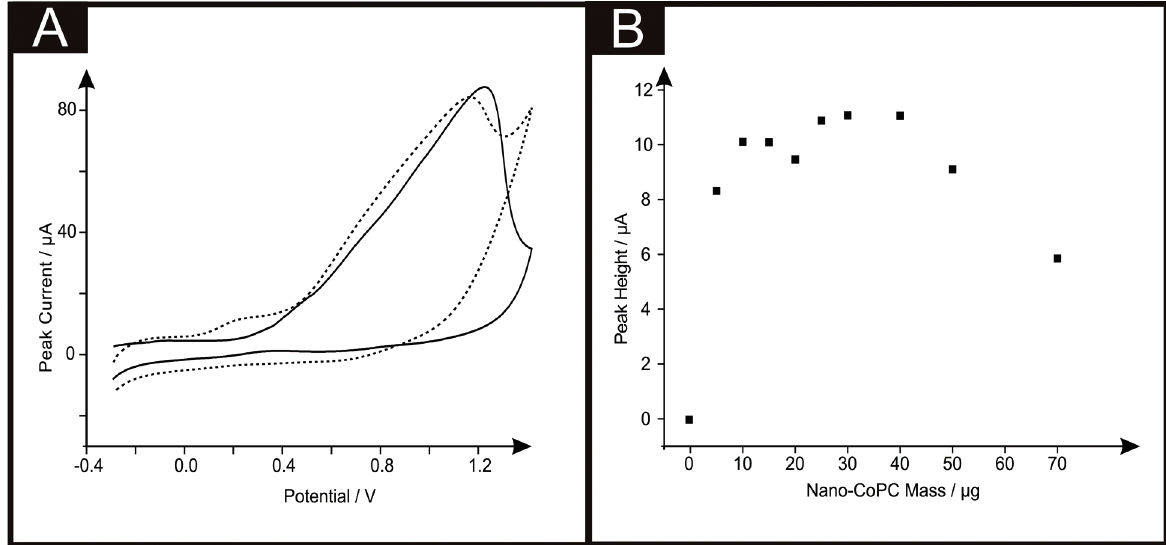
Figure 6. Cyclic voltammograms ( A ) utilising a standard-SPE (solid line), a 20 µg nano-CoTAPC SPE in the presence (dotted line) and absence (dashed line) of 500 µM Hydrazine in pH 7.4 PBS. Corresponding plots of nano-CoTAPC mass vs. peak height ( B ). Scan rate: 100 mV s − 1